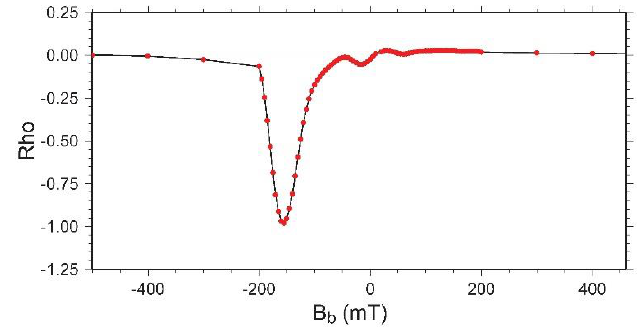
Figure 8. Reversible ridge for Bc = 0.